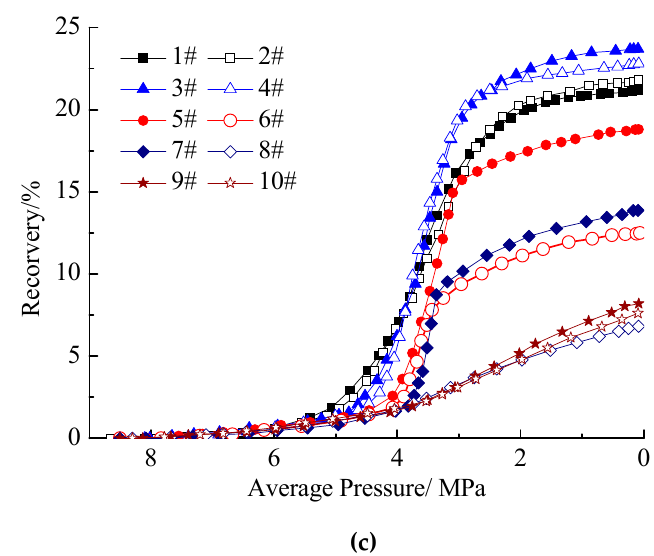
Figure 3. Production behavior for the ten depletion experiments. ( a ) Change in average pressure with time. ( b ) Change in production gas–oil ratio with average pressure. ( c ) Change in oil recovery with average pressure.